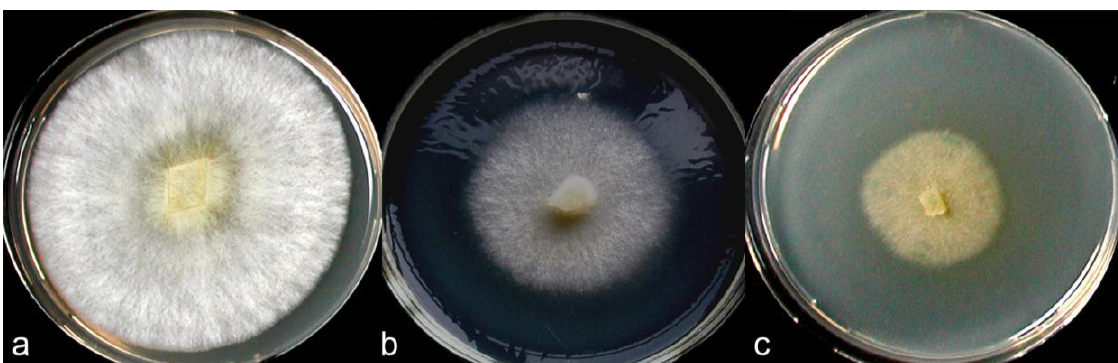
Figure 7. Colony morphology of C. aff. radians strain 1-2PS on different agar media at day 7 of cultivation at 25 °C: (a) MEA (pH 6.0), (b) PDA (pH 6.0), and (c) GPA (pH